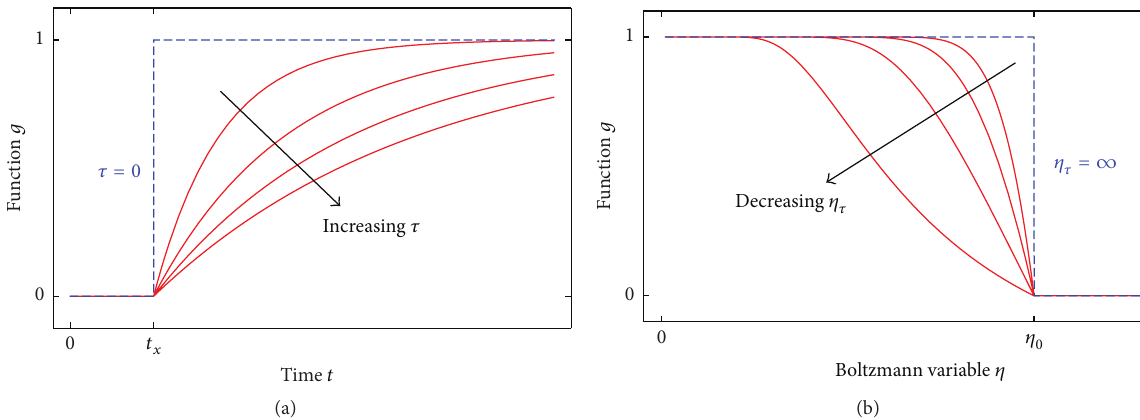
Figure 1: (a) The function 𝑔(𝑥,𝑡) at a fixed position 𝑥 for several values of the relaxation time 𝜏 (the full lines). The step-wise form (the dashed line) corresponds to an immediate binding of salt ( 𝜏 = 0 ). (b) The corresponding function 𝑔(𝜂)